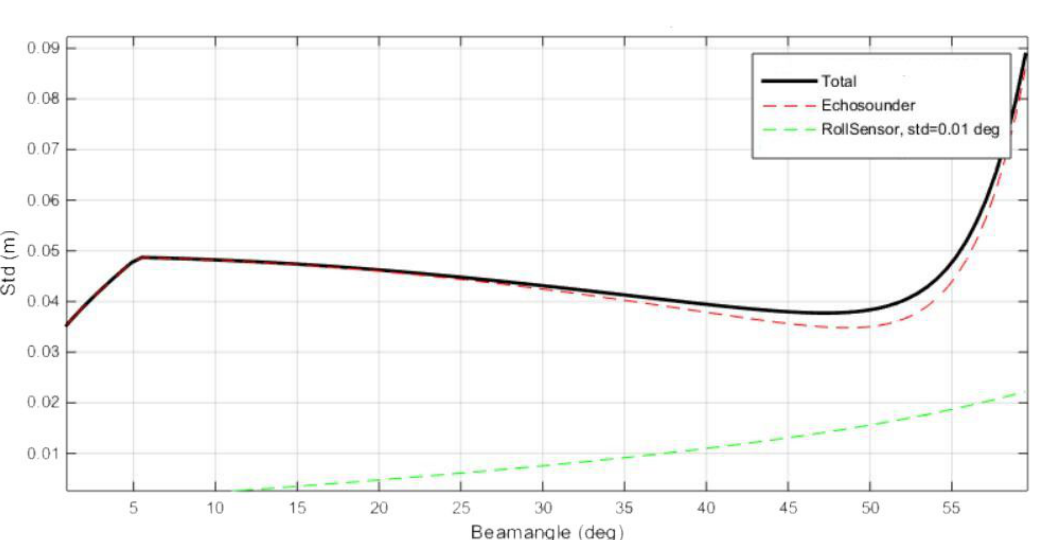
Figure 21. Estimated vertical resolution across swath for EM 2040 multibeam echosonder, calculated for the following parameters: single swath, continuous wave, bandwidth of 5.0 kHz, noise level of 45 dB, and water depth of 75 m.